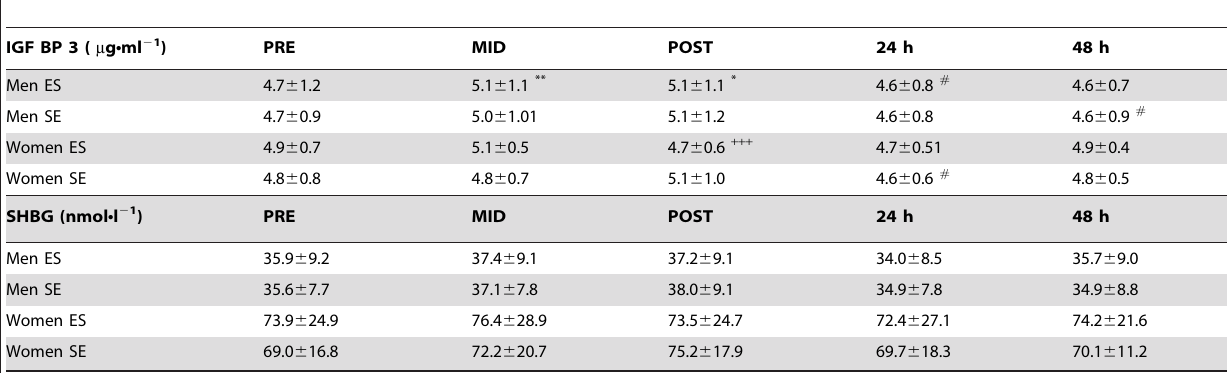
Table 2. Absolute concentrations of insulin-like growth factor 1 binding protein 3 and sex-hormone binding